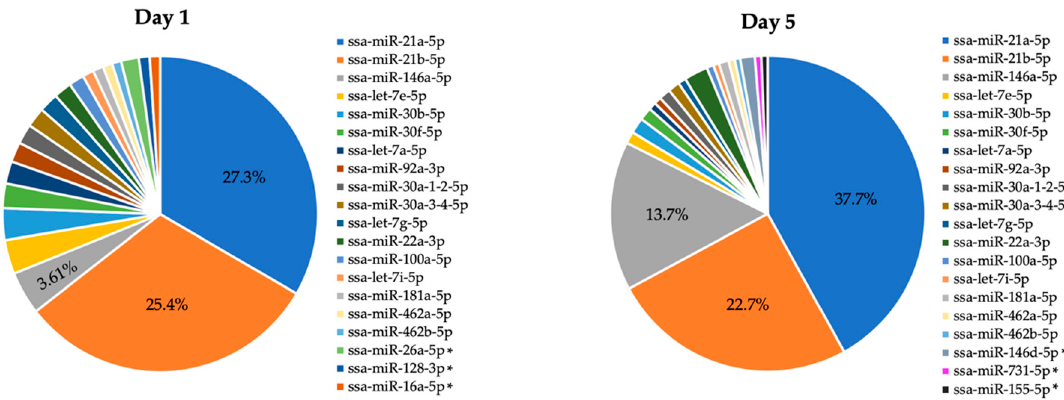
Figure 2. miRNA expression and diversity (average normalized read counts of 370 miRNAs) in Day 1 and Day 5 Atlantic salmon adherent HKLs. The top 20 most abundant miRNAs in Day 1 and Day 5 are indicated. * indicates miRNAs present in the top 20 of one day but not the other day.